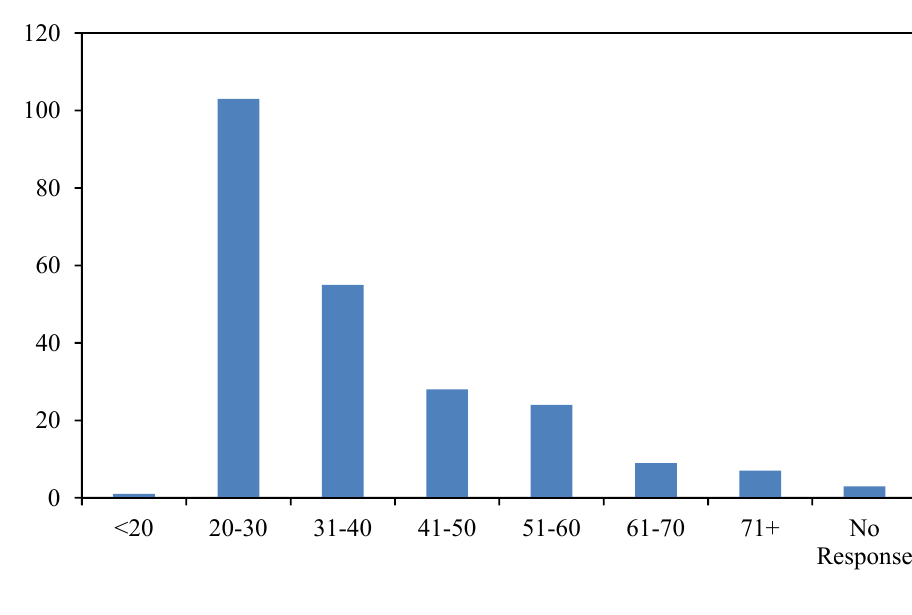
Figure 2. Graph of age distribution of respondents.